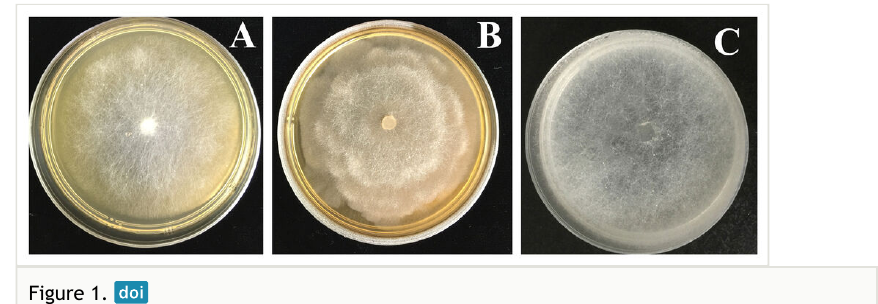
Etymology With reference to the distribution of the species in the Huang-Huai area of China.